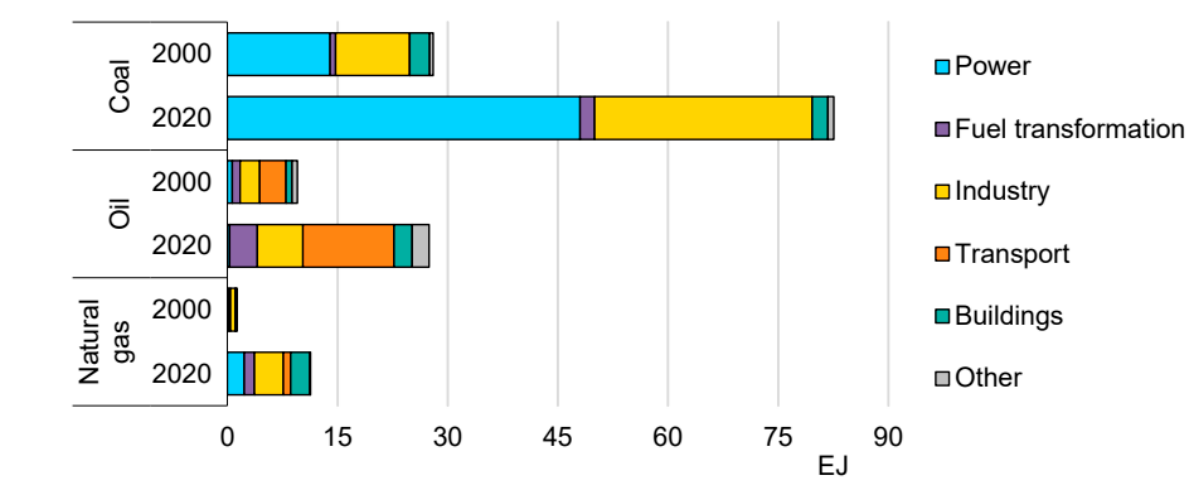
Figure 3. Fossil fuel consumption by sector in China.